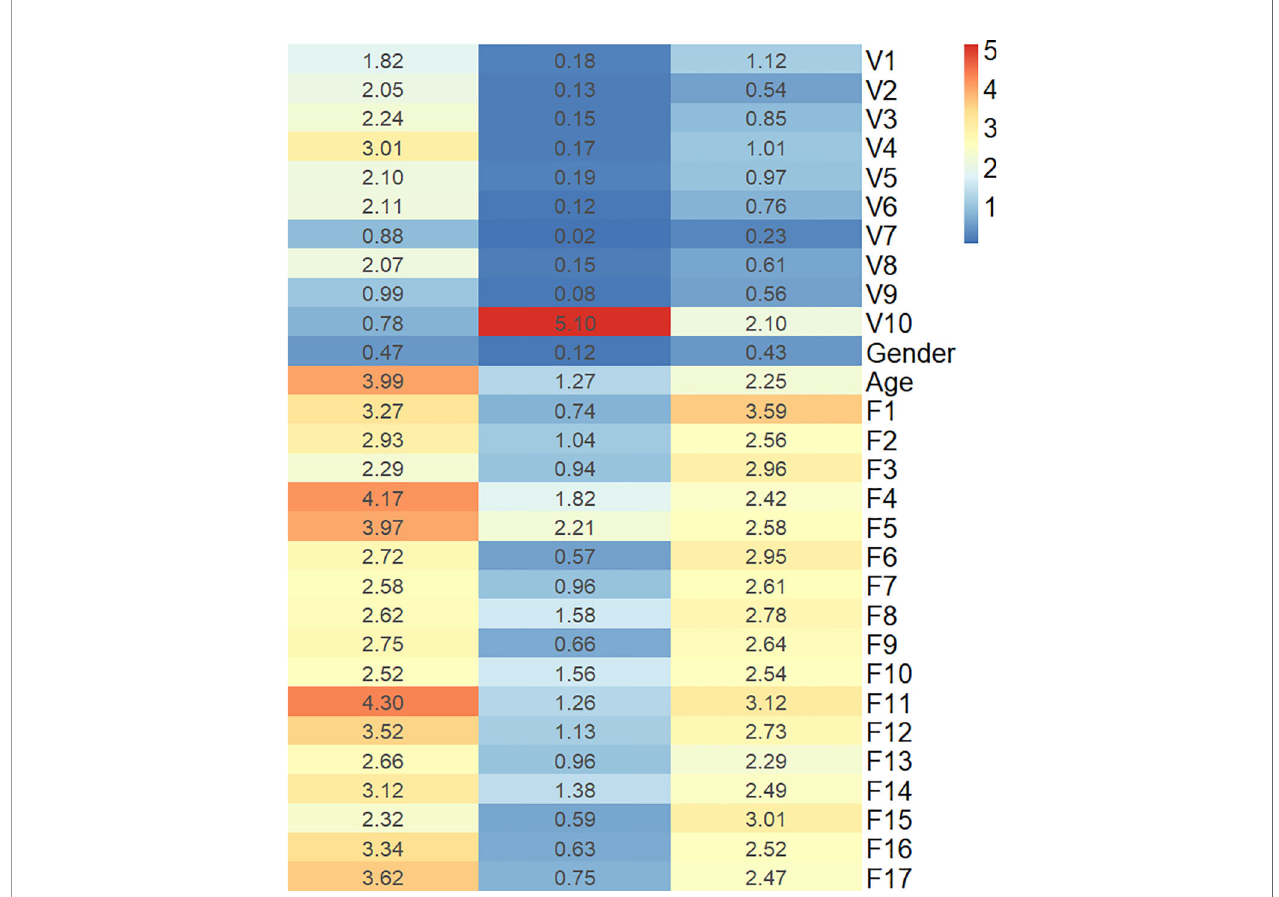
FIGURE 3 | Heat map of the subtype-speci fi c importance of all features used in subtype classi fi cation.